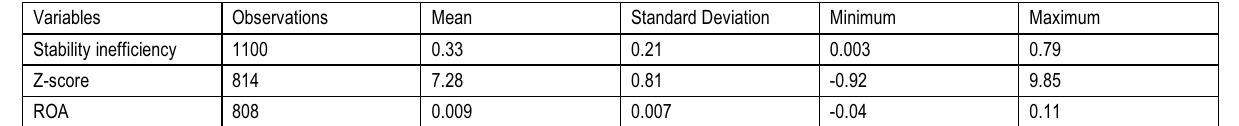
Table 1 Descriptive statistics of the